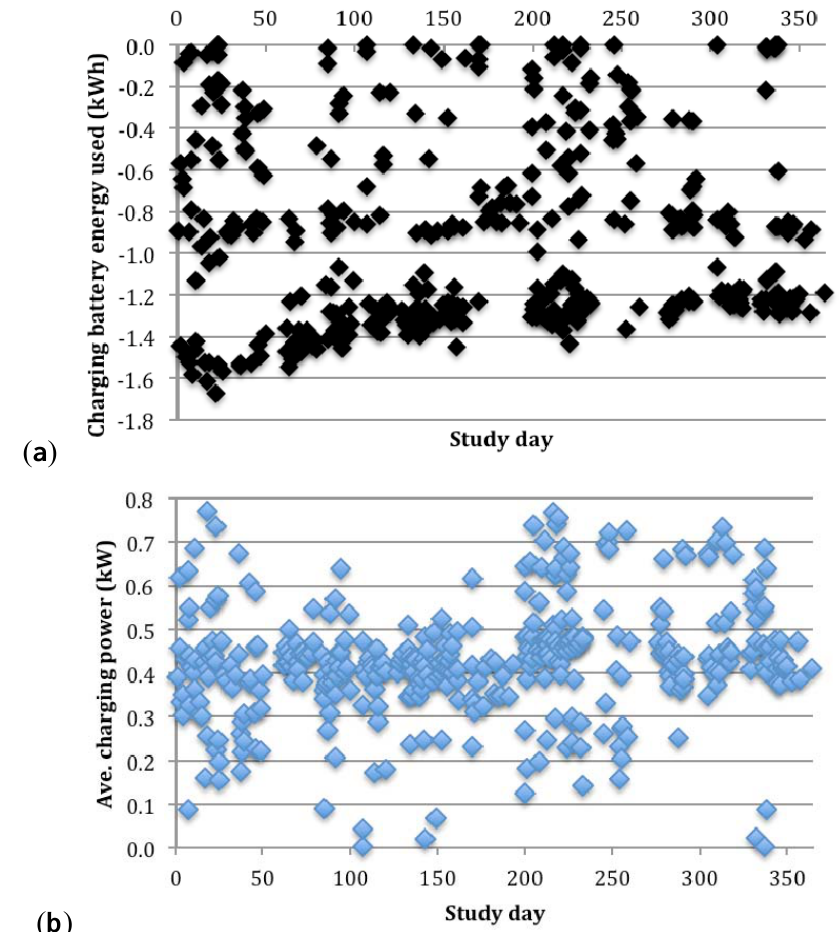
Figure A-3. Charging ( a ) battery energy used and ( b ) average